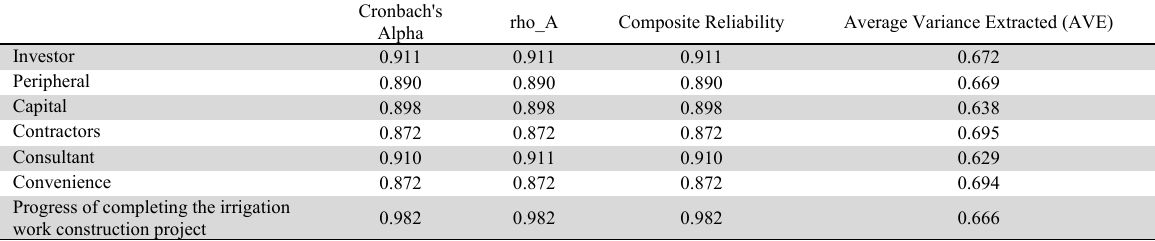
Construct Reliability and Validity